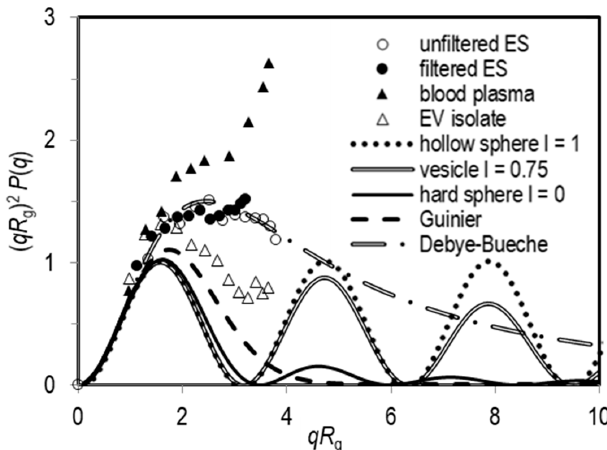
Figure 3. The intensity of scattered light measured by static light scattering (SLS) and represented as the Kratky plot ( i.e., ( qR g ) 2 P ( q ) versus qR g ) for the population 2 (large particles; see text) in the exosome standard ES (open circles: unfiltered; full circles: filtered), a plasma sample (full triangles) and the corresponding EV isolate from the same sample (open triangles). The lines show the calculated ( qR g ) 2 P ( q ) versus qR g dependencies for some selected shapes (for details see Supplementary Material).